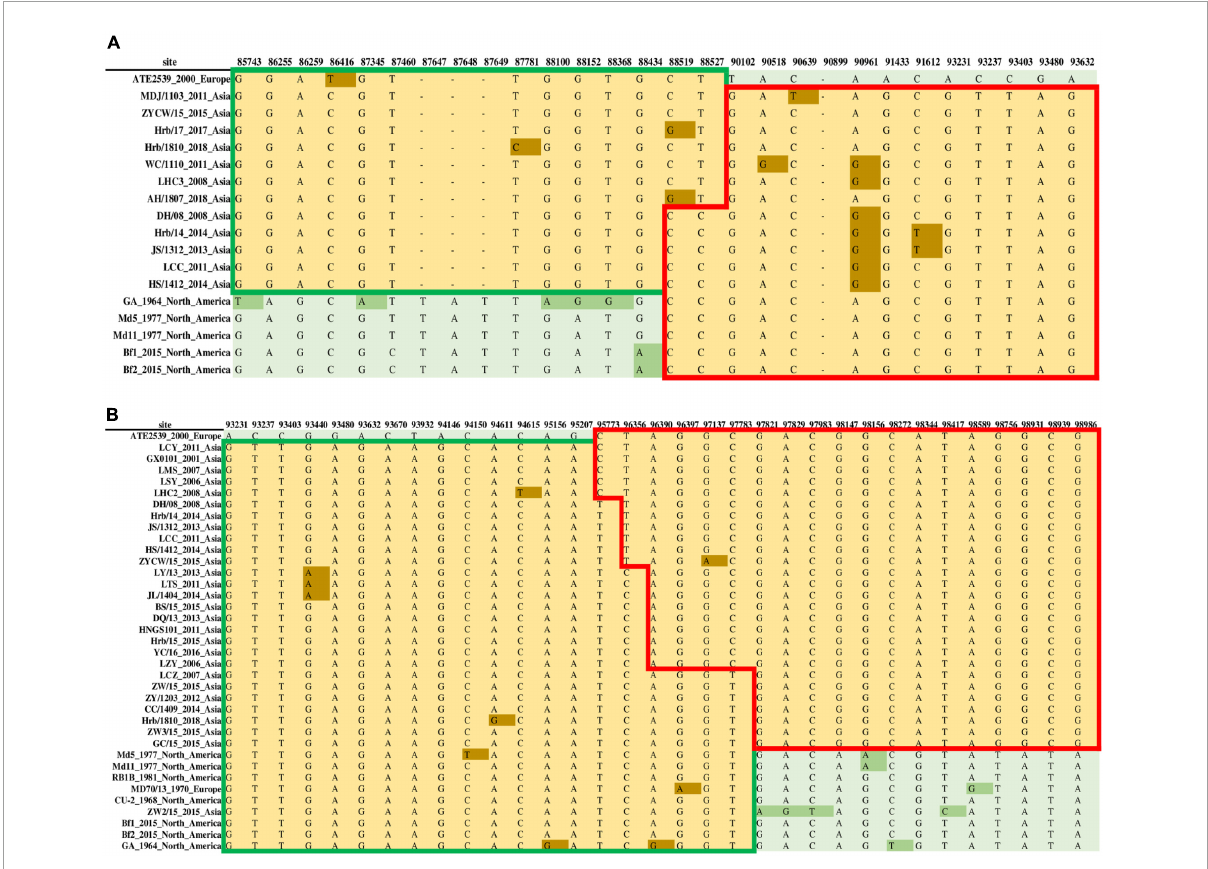
FIGURE7 Two forms of recombination in the unique long (UL) sub-region involving the Marek’s disease virus (MDV) European strain ATE2539. (A) The recombination of the European strain ATE2539 with North American strains produced Asian strains. (B) The recombination of the European strain ATE2539 with North American strains, the European strain MD70/13, and Asian strain ZW2/15 produced the prevalent Asian strains.